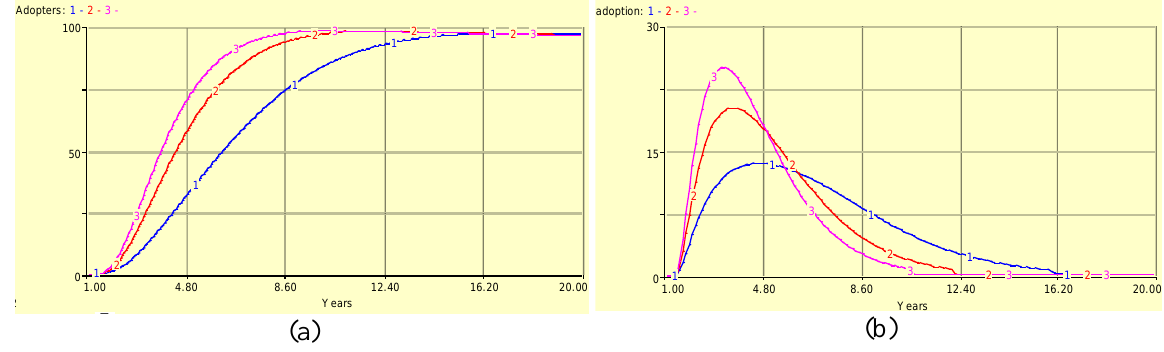
Fig. 5. Sensitivity analysis behaviour based on promotional